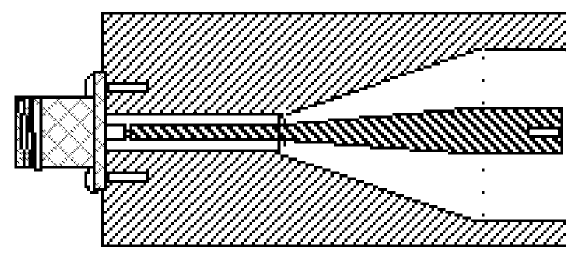
FIG. 10. The Faraday cup; the outside diameter is 5